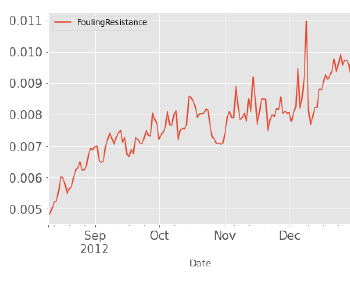
Figure 7. Working months vs Fouling